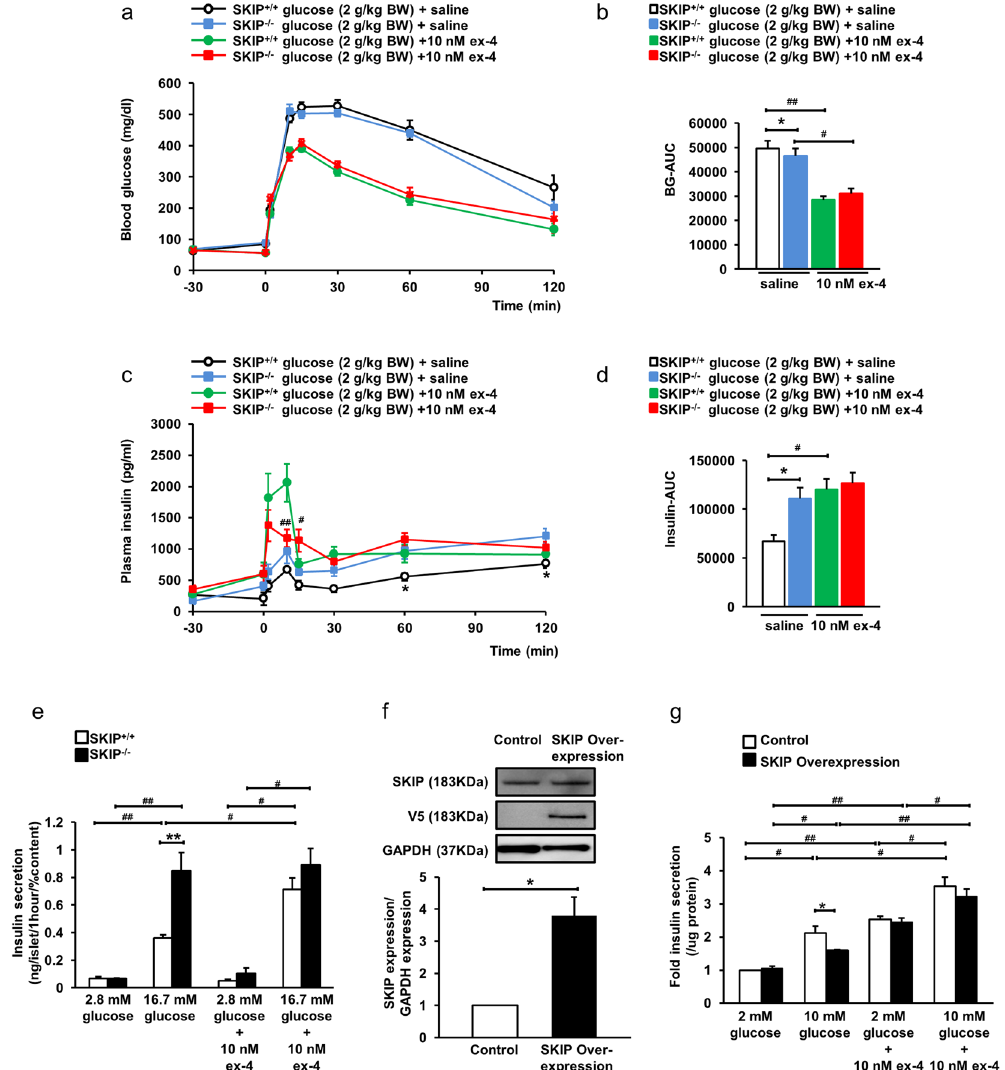
Figure 5. Exendin-4-enhanced Insulin secretion in SKIP + / + mice and SKIP − / − mice. ( a – d ) Blood glucose levels ( a ), BG-AUC ( b ), plasma insulin levels ( c ) and insulin-AUC ( d ) during 2 g/kg body weight IpGTT 30 min after administration of 10 nM ex-4. ( e ) Ex-4-induced insulin secretion in the islets from SKIP + / + mice and SKIP − / − mice. Insulin secretion from isolated islets measured at 2.8 mM and 16.7 mM glucose with or without 10 nM ex-4. ( f ) Protein expression of SKIP in control and SKIP-overexpressed INS-1D cells after 48 h transfection detected by western blot with anti-rat SKIP antibody. The membrane was reprobed with anti-V5 antibody, and reprobed with anti-GAPDH antibody as control. All gels were run under the same experimental conditions. Uncropped images of blots/gels are shown in Supplemental Figure 6 (n = 3). ( g ) Insulin secretion in SKIP-overexpressed INS-1D cells measured at 2 mM and 10 mM glucose with or without 10 nM ex-4. ( a – e ) 12-week-old mice were used for the experiments. ( a , c ) # p < 0.05 SKIP − / − ex-4 vs SKIP + / + ex-4. ( b , d ) * p < 0.05, ** p < 0.005 SKIP − / − saline vs SKIP + / + saline, # p < 0.05, ## p < 0.005 for different stimulated conditions in the same genotype mice. ( e ) n = 7–8 mice per group and 5–6 samples per group, with 10 islets per sample, * p < 0.05, ** p < 0.005 vs SKIP + / + , # p < 0.05, ## p < 0.005 for different stimulated conditions in the same genotype mice of insulin secretion. ( g ) Data from 4 experiments are shown, * p < 0.05 vs control, # p < 0.05, ## p < 0.005 for different stimulated conditions in the same cells. All data are expressed as average ± SEM. Significance was determined by one way ANOVA with Tukey test ( a – e , g ) and student’s t-test ( f